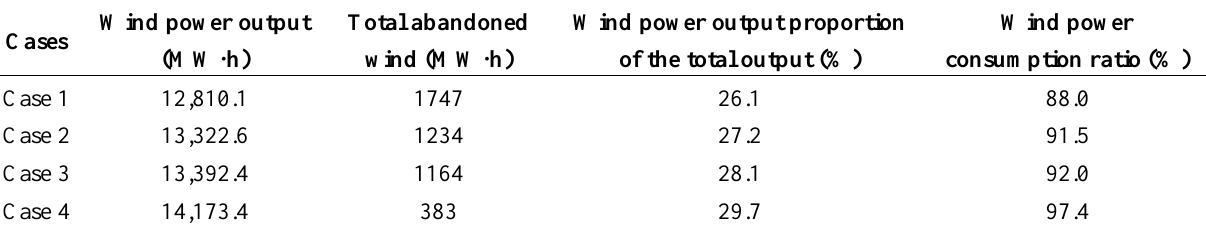
Table 4. Wind power consumption situations in four cases.